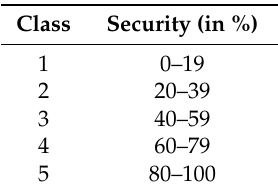
Table 8. Overview of the windfall securities